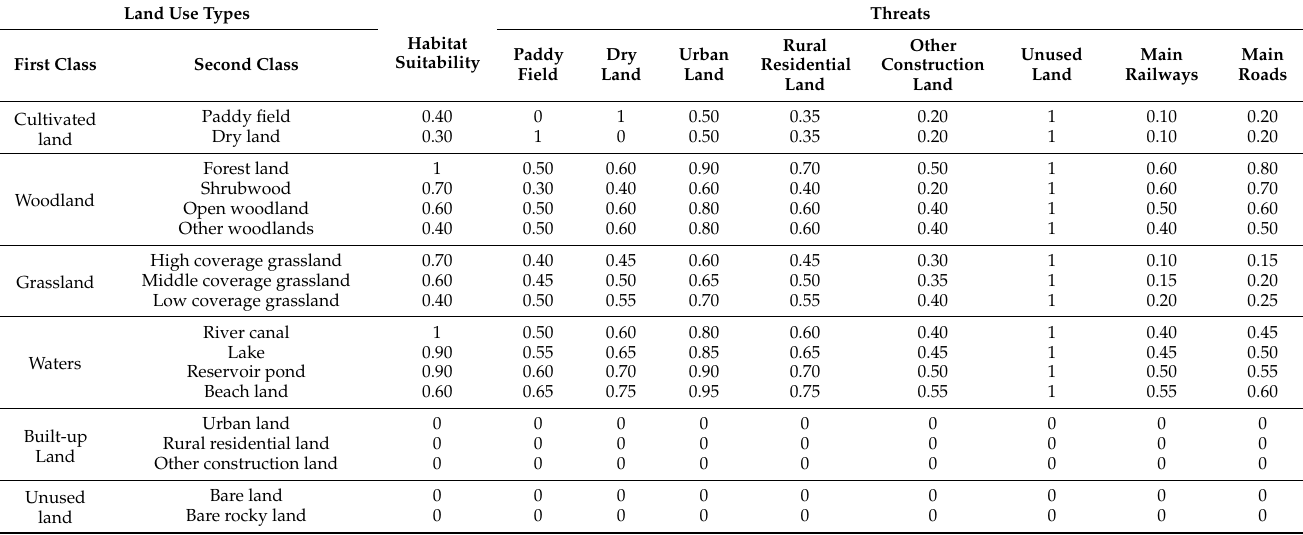
Table 3. Habitat suitability degree and relative sensitivity of habitat types to each